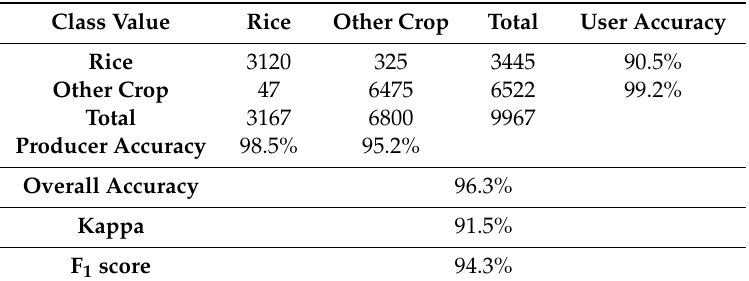
Table 2. Confusion matrix for decisional tree classification.